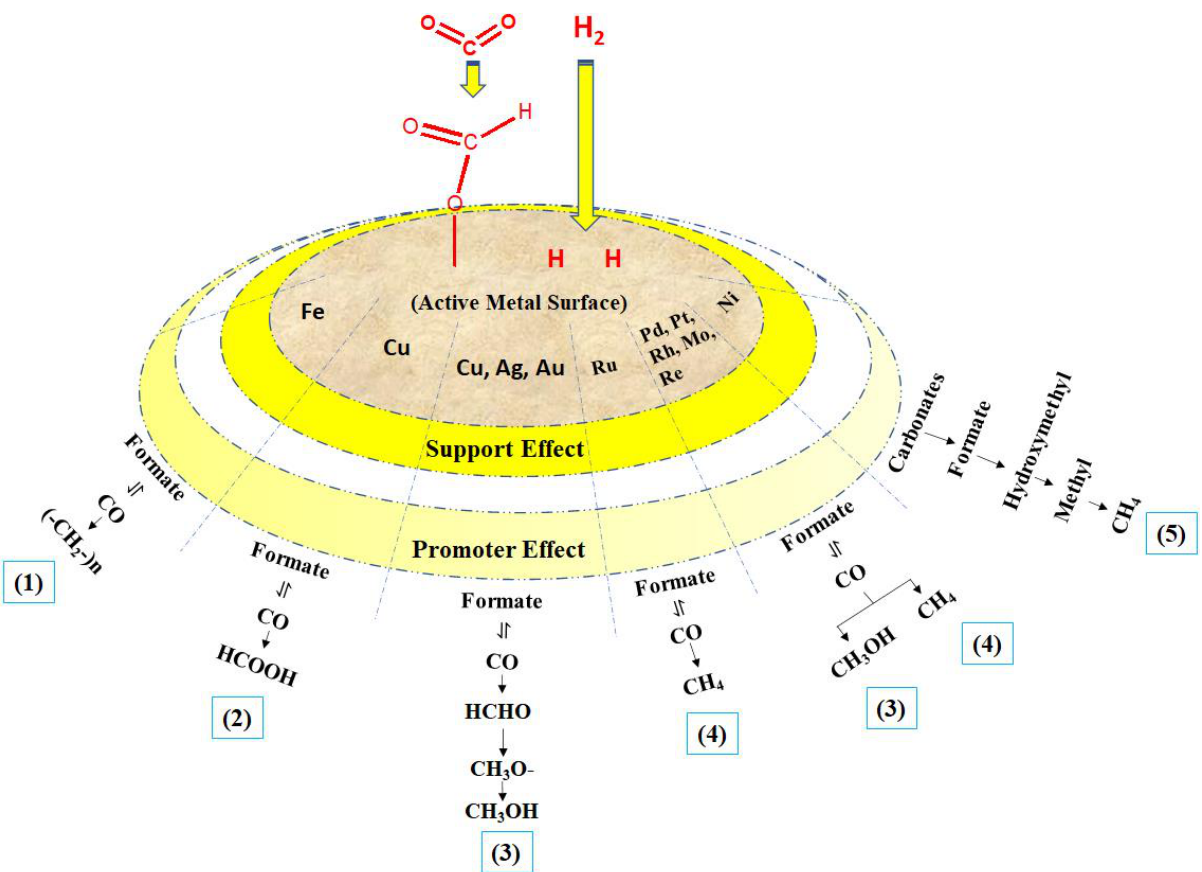
Figure 1. Reaction scheme of CO 2 and H 2 interaction over supported metal catalyst.